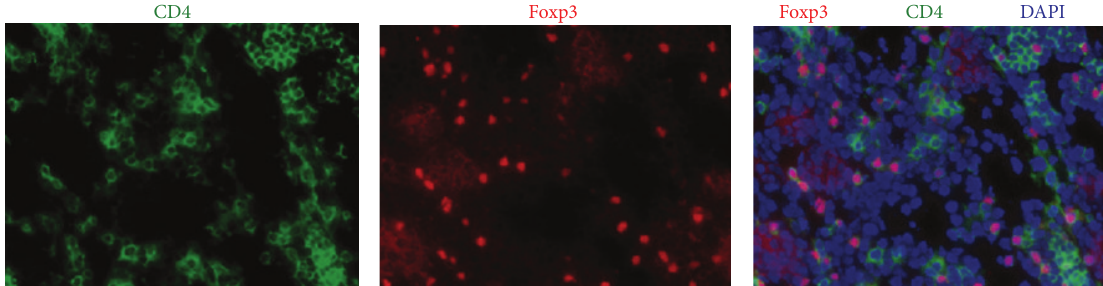
Figure 2: Detection of Foxp3-positive cells in the pancreas. Single immunostaining of CD4 (green; FITC) and Foxp3 (red; Cy3) in poly I:C-treated MRL/Mp mice at the age of 18 weeks. Nuclei were stained by DAPI (blue nuclear stain). The merged images demonstrated many mononuclear cells double positive for CD4 and Foxp3 in the pancreas. The most Foxp3-positive cells appeared in the CD4-positive cells ( × 400).